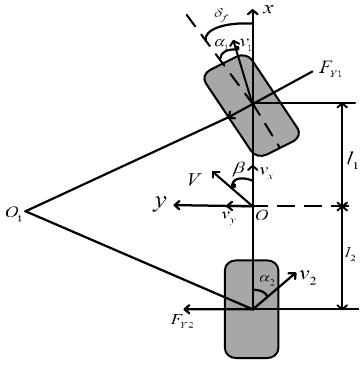
Figure 4. Two DOF vehicle model.